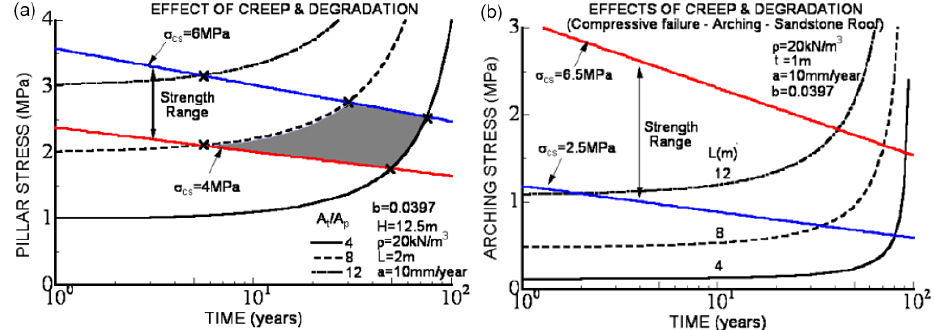
Figure 4. Effects of degradation and creep loading on failure time of pillars and roofs ( σ cs : short-term uniaxial compression strength; ρ : unit weight of surrounding rock; A t : supported area; A p ; pillar height; L : room width; a : empirical coefficient of degradation function; b : empirical coefficient of long-term strength function, see Aydan et al., 2006 for details). (a) Pillar. (b) Roof consisting